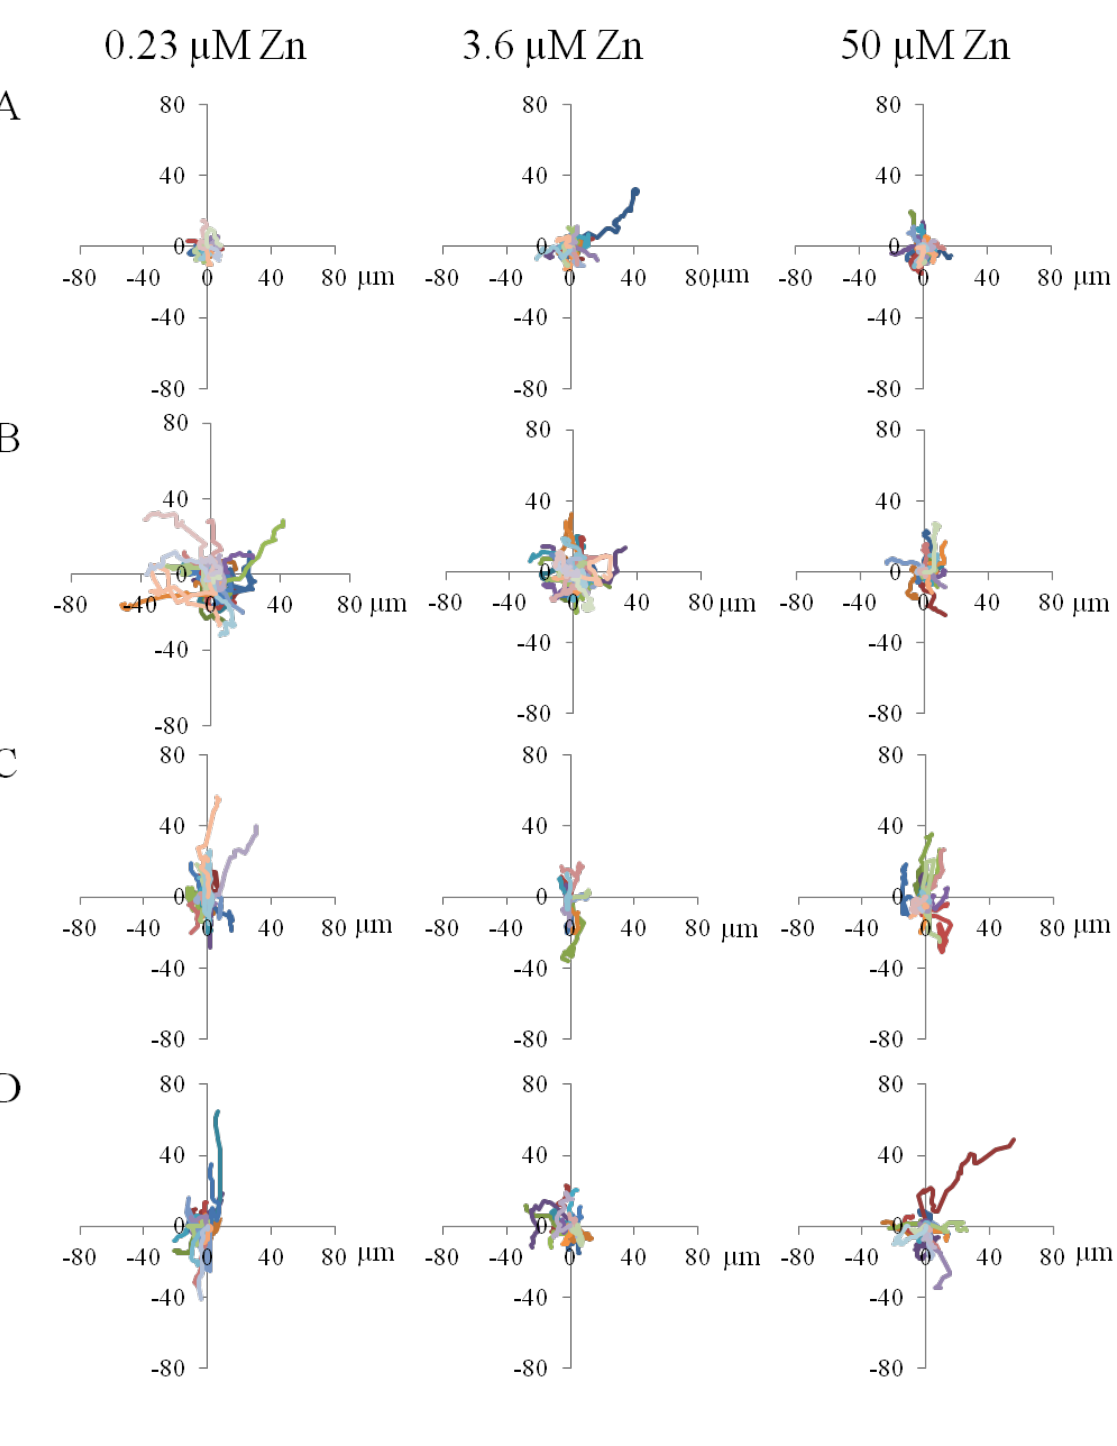
Figure 5. Displacement paths of subclone 4 MC3T3-E1 cells in various zinc-modified media after attaching for 2 hours on ( A ) TC; ( B ) flat PDMS; ( C ) 20 µm wide/30 µm wide patterned PDMS ridges; and ( D ) 2 µm wide/10 µm narrow patterned PDMS ridges. Colored lines represent the migration paths tracked using time-lapse video microscopy; ( E ) Migration speeds of MC3T3-E1 cells on various substrates with modified zinc levels. A single asterisk ( * ) indicates a p < 0.01 level of